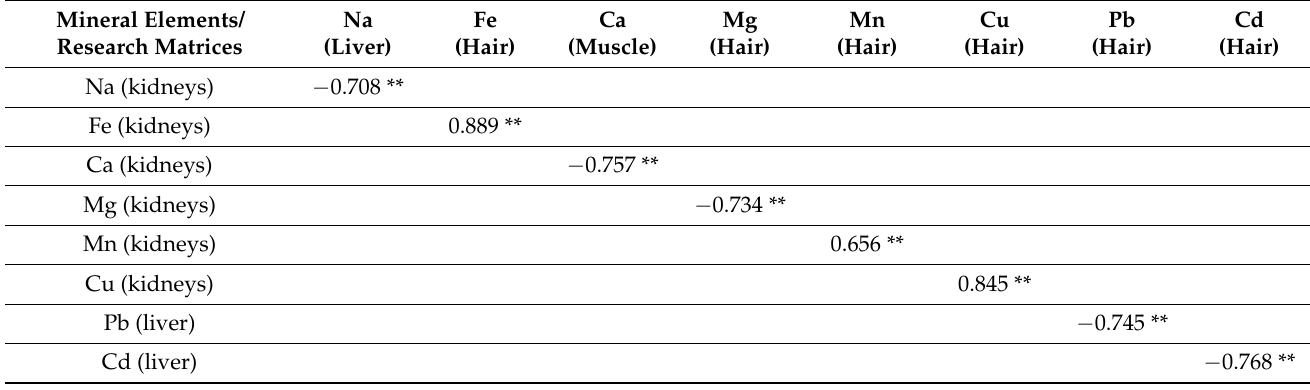
Table 4. Strong significant correlations between the concentrations of the same elements in different organs and tissue— interaction coefficients.